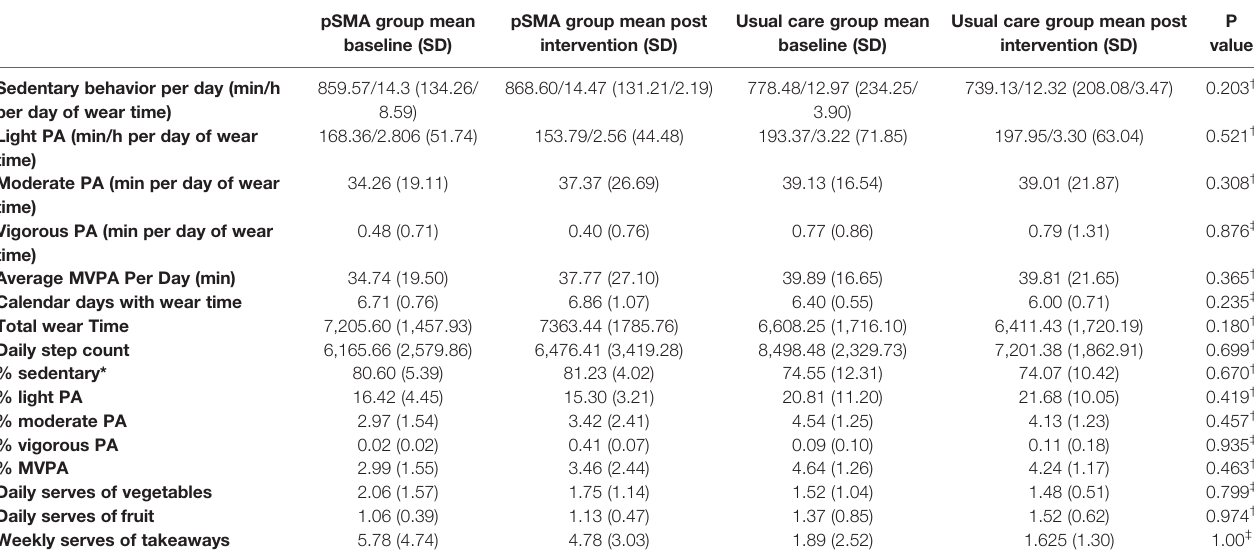
TABLE 8 | Diet and physical activity habits at baseline and 12 weeks.